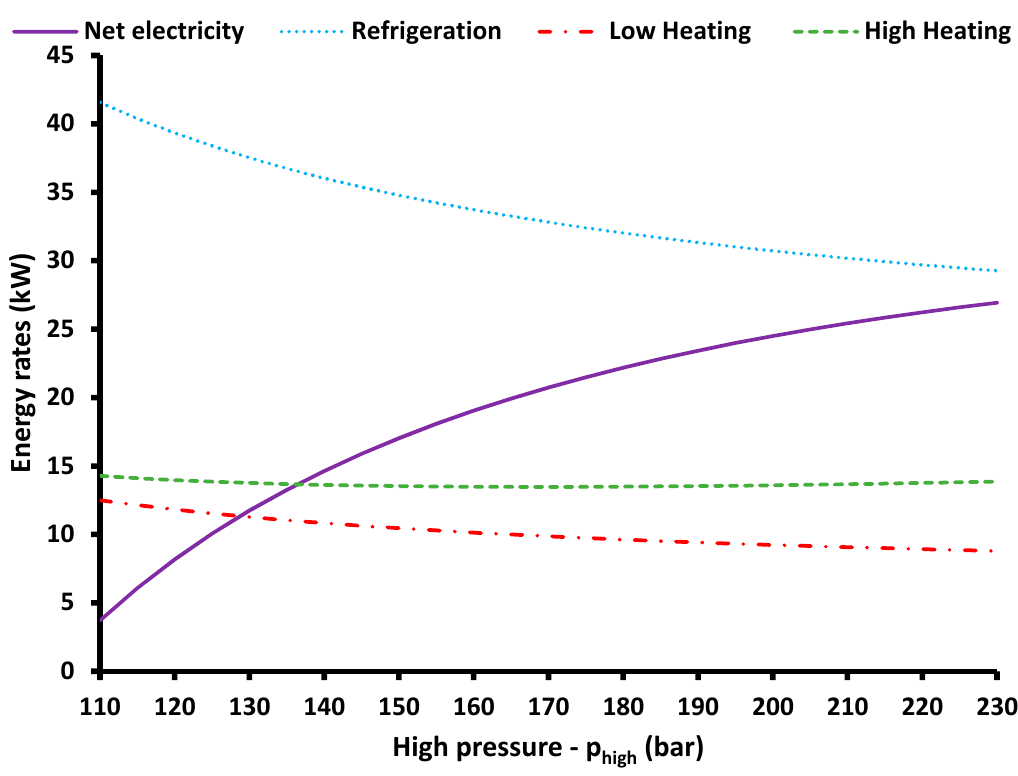
Figure 6. Useful energy products for different values of the high pressure.